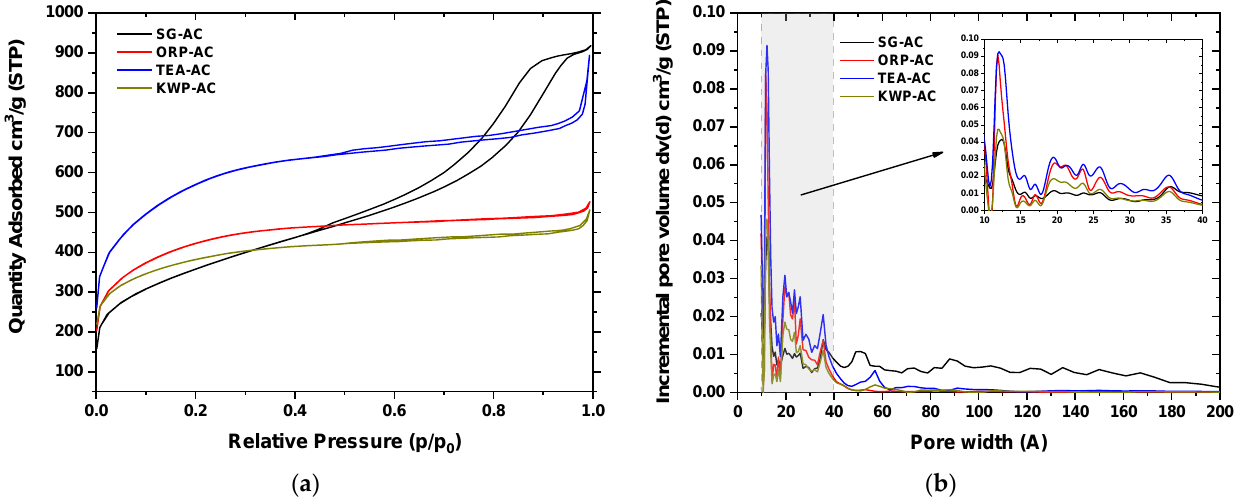
Figure 5. ( a ) Nitrogen physisorption isotherms of the prepared AC samples; ( b ) Pore size distributions for the prepared AC samples.